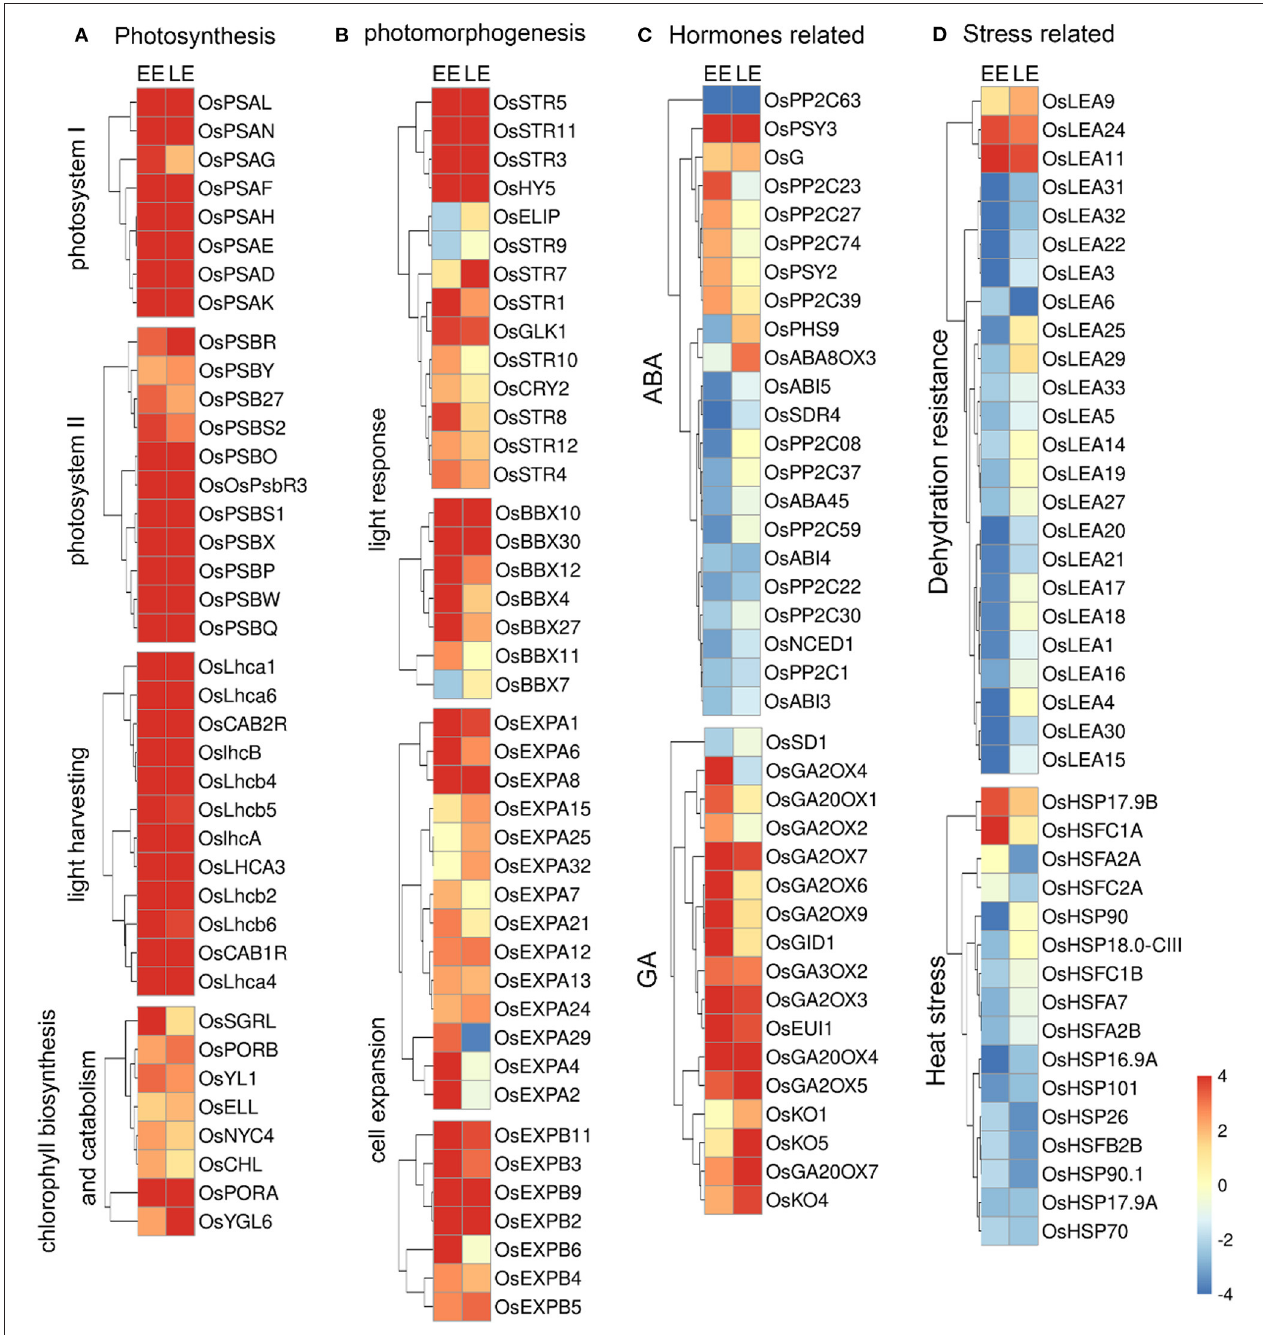
FIGURE 5 | Heat maps of differentially expressed genes in Oslec1 embryos. (A) Heat maps of genes involved in photosynthesis, (B) photomorphogenesis, (C) hormone pathways, and (D) stress responses, including dehydration resistance and heat stress response.